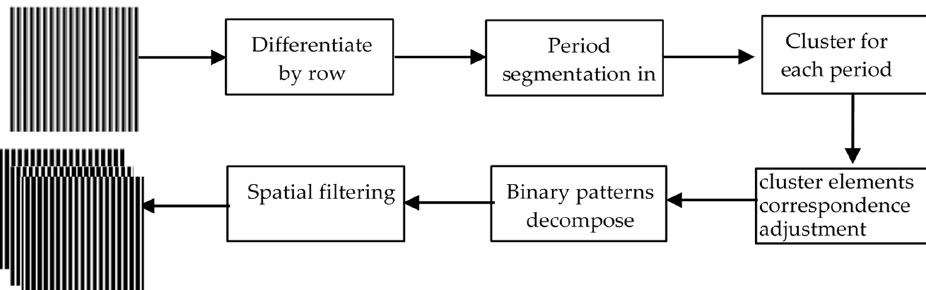
Figure 7. Fringe segment procedure.